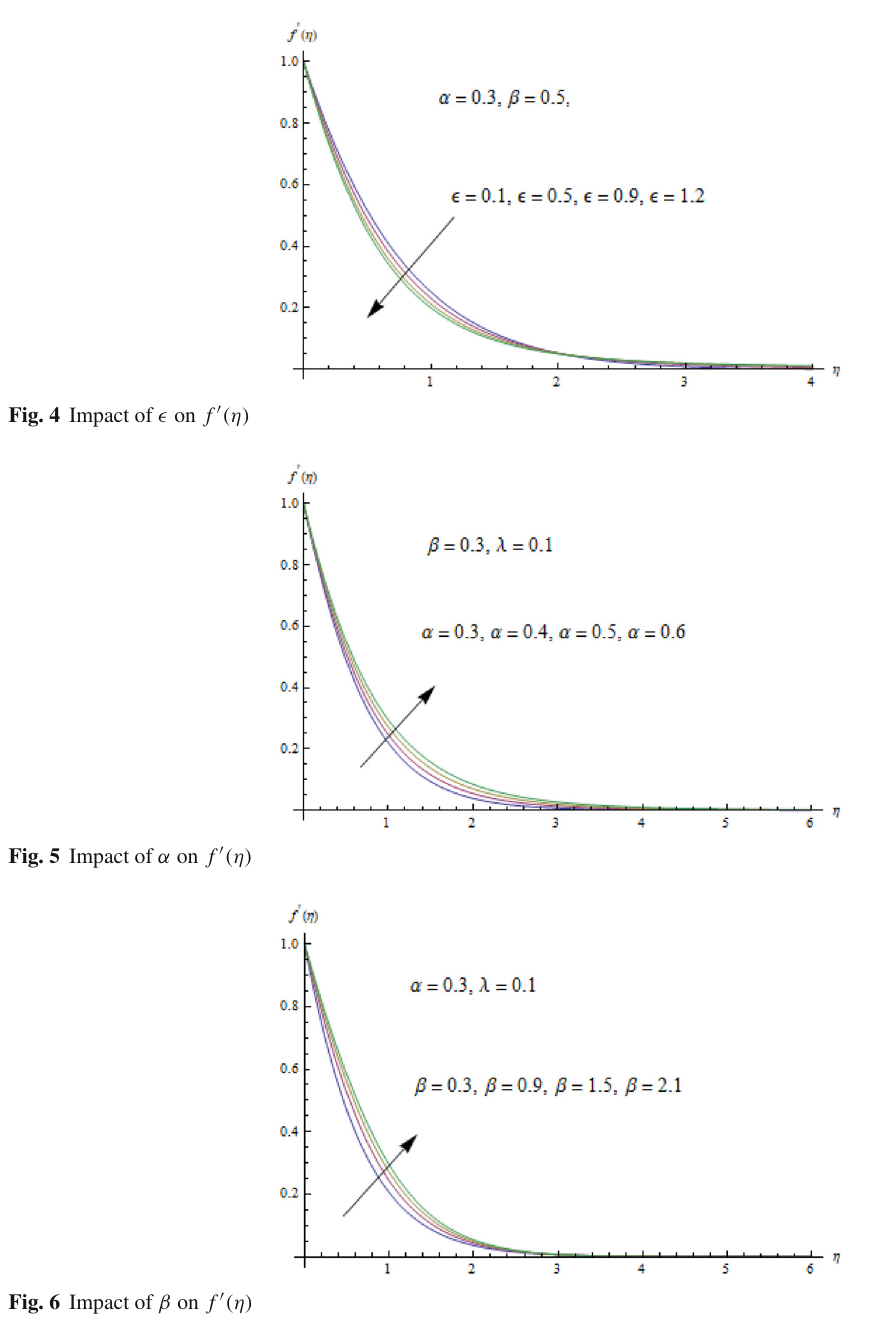
Fig. 6 Impact of β on f (cid:5)